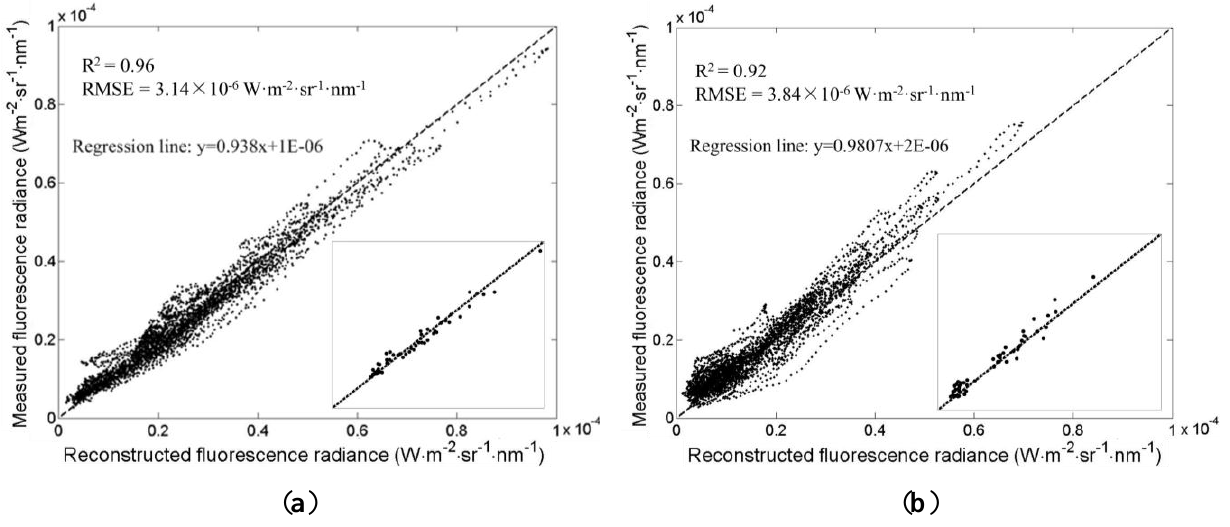
Figure 9. Comparison between the leaf fluorescence radiance spectra reconstructed from the inverted fluorescence parameters and the leaf fluorescence radiance spectra measured in the experiment for ( a ) backward and ( b ) forward fluorescence radiance. Insets: Comparison between reconstructed and measured fluorescence radiances at 690 and 740 nm with the same